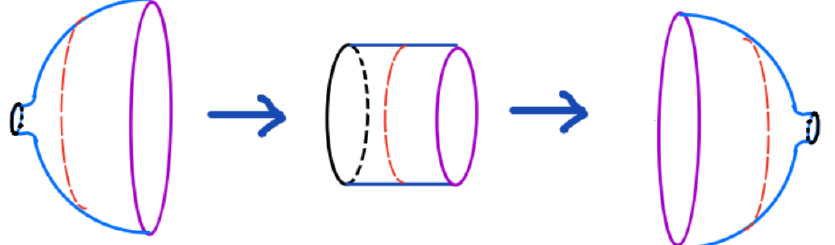
Figure 15. The “inside-out transition” in which a small black hole horizon and the cosmic horizon interchange by passing through the intermediate Nariai black